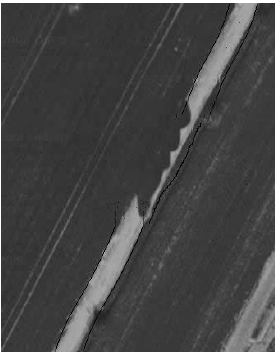
Figure 18: Extraction of Road Using Ribbon Snake and Ziplock Snake